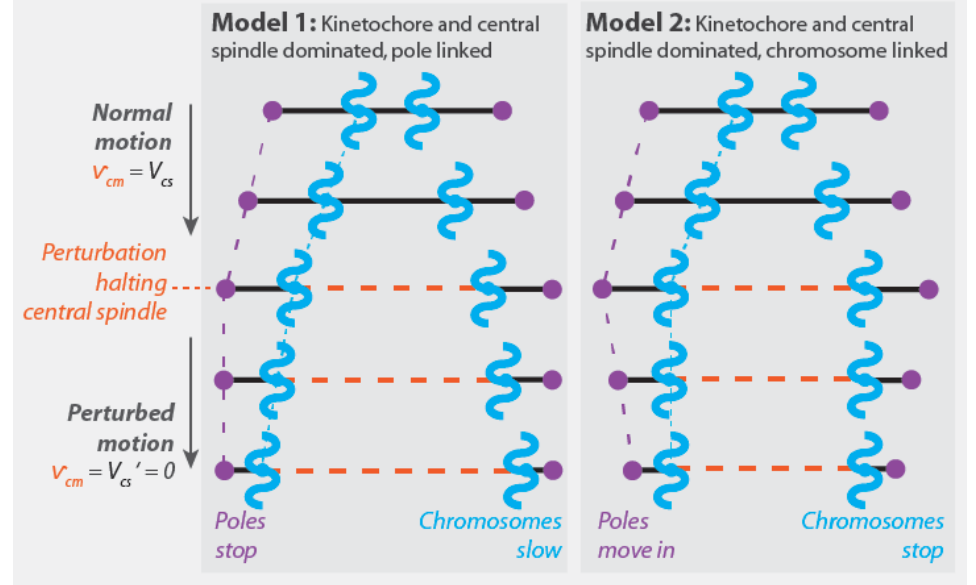
Figure 6. Experimental perturbations can be used to differentiate between different mechanical models of anaphase. For a perturbation that selectively halts the motion of the central spindle microtubules (i.e., by causing the preferred speed of the central spindle microtubules, V cs , to become zero, V cs → V (cid:48) cs = 0), Models 1 and 2 (Figure 5A,B) both predict that the speed of the central spindle microtubules, v cm , becomes zero (i.e., v cm = V (cid:48) cs = 0). However, this change leads to different subsequent motions of chromosomes and poles in the two models. In Model 1, this perturbation causes spindle poles to cease moving, while chromosome motion continues (at a reduced rate). In Model 2, this perturbation causes chromosomes to cease moving. In both Models 1 and 2, this perturbation is predicted to have no impact on the relative motion of chromosomes and